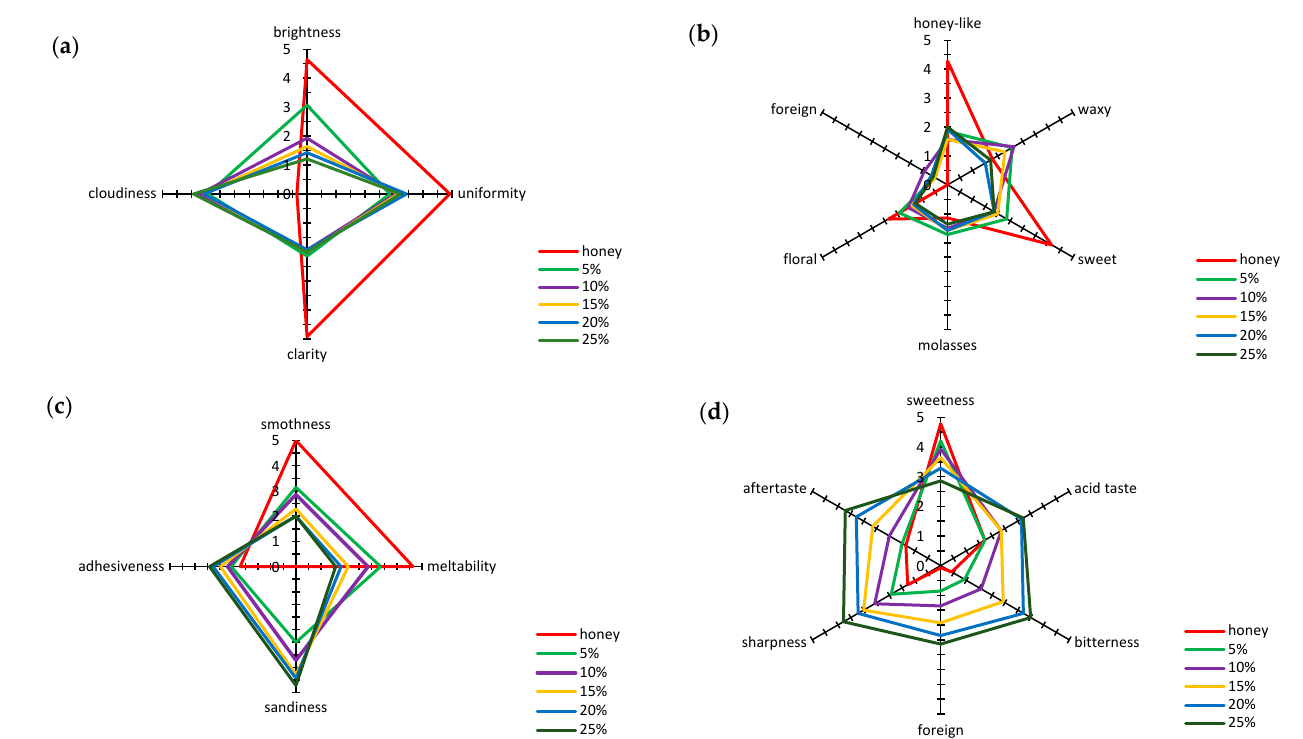
Figure 1. The results of sensory profiling analysis for the ( a ) color, ( b ) smell, ( c ) texture, and ( d ) taste of multiflower honey and honey samples enriched with bee pollen.